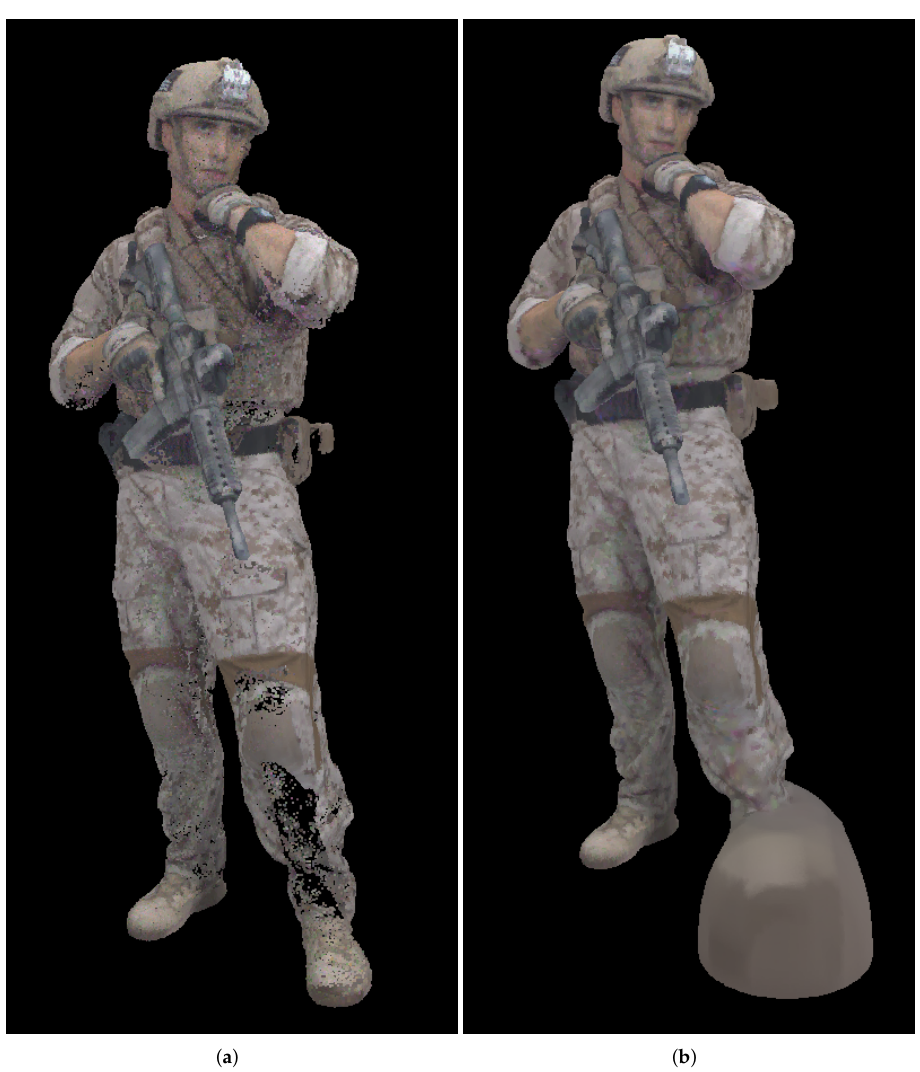
Figure 20. Decompressed point cloud Soldier , “soldier_vox10_0537.ply”-second point cloud used in compression/decompression process, using cylindrical projection with panorama size of 2,000,000 points: ( a ) before Poisson reconstruction (point size 2 in MeshLab); ( b ) after Poisson recon- struction (point size 1 in MeshLab). Table 11. Octree reduction using 3DTK toolkit, with voxel size “R” = 1 and different parameters